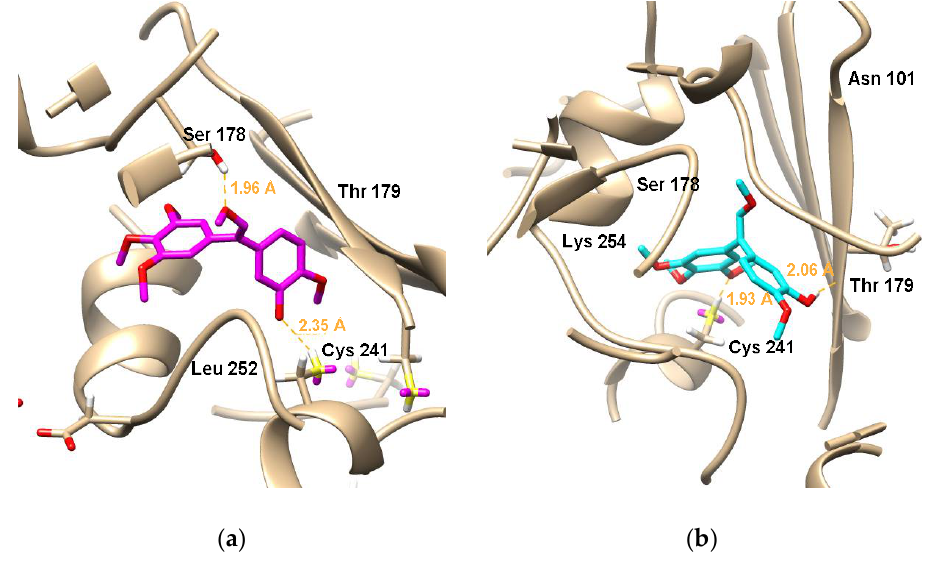
Figure 7. Molecular docking simulations obtained at lowest energy conformation, highlighting potential hydrogen contacts of ( a ) 6b-( Z ) and (b) 6b-( E ) with the colchicine’s binding site of tubulin (PDB code: 1SA0). Surrounding key amino acid residues are labeled, and hydrogen bonds are shown by orange dashed lines.